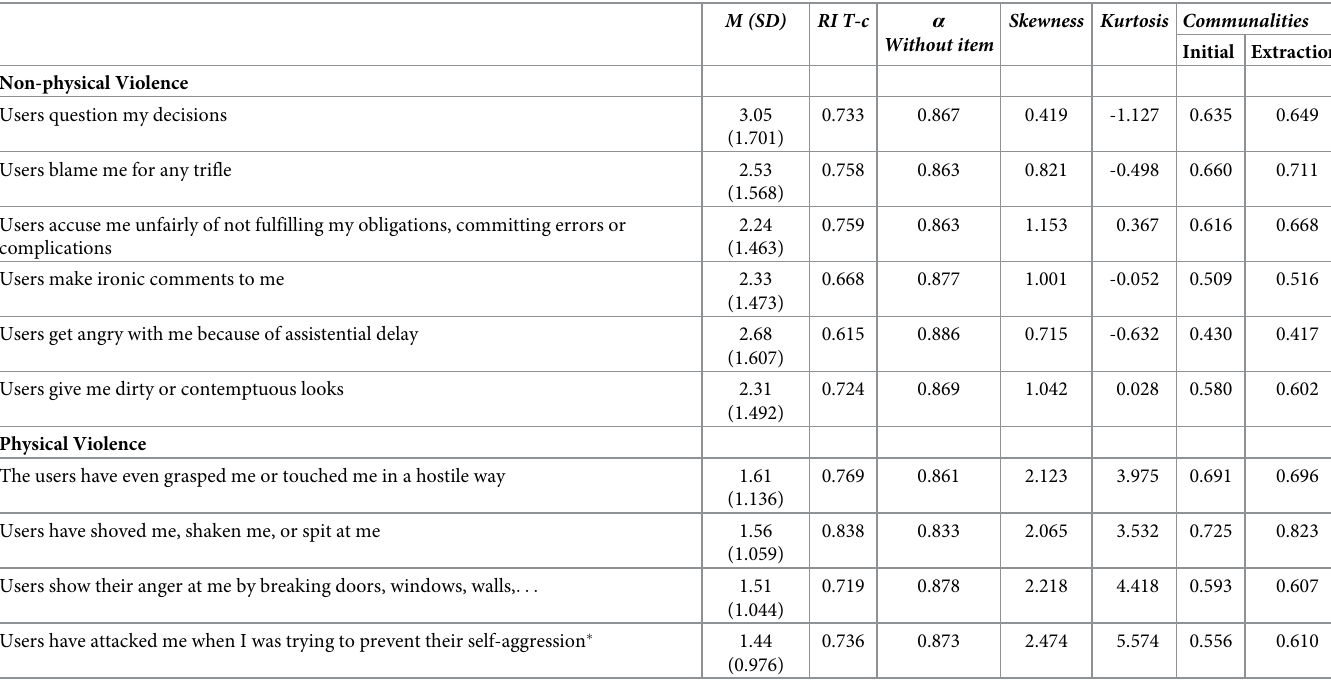
Table 2. Descriptive statistics of the